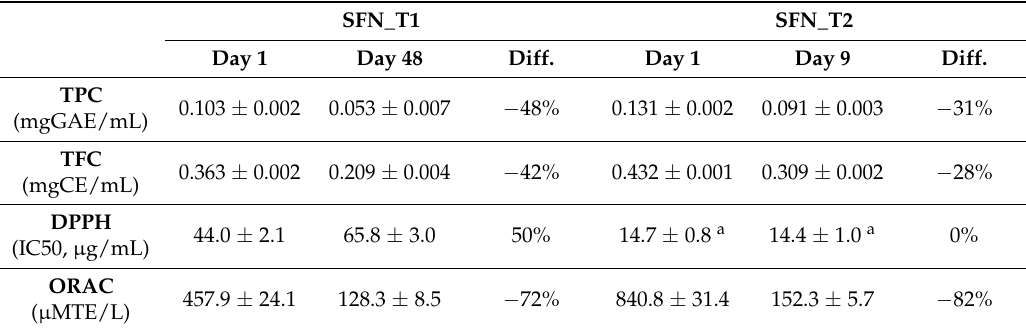
Table 3. TPC, TFC, DPPH (IC50), and ORAC levels, with the respective standard deviations, measured at different times after tests SFN_T1 and SFN_T2. Data refer to samples collected after 60 min of process time in each test. Superscripts indicate indistinguishable values ( p > 0.05). Difference expressed as % change compared to the initial